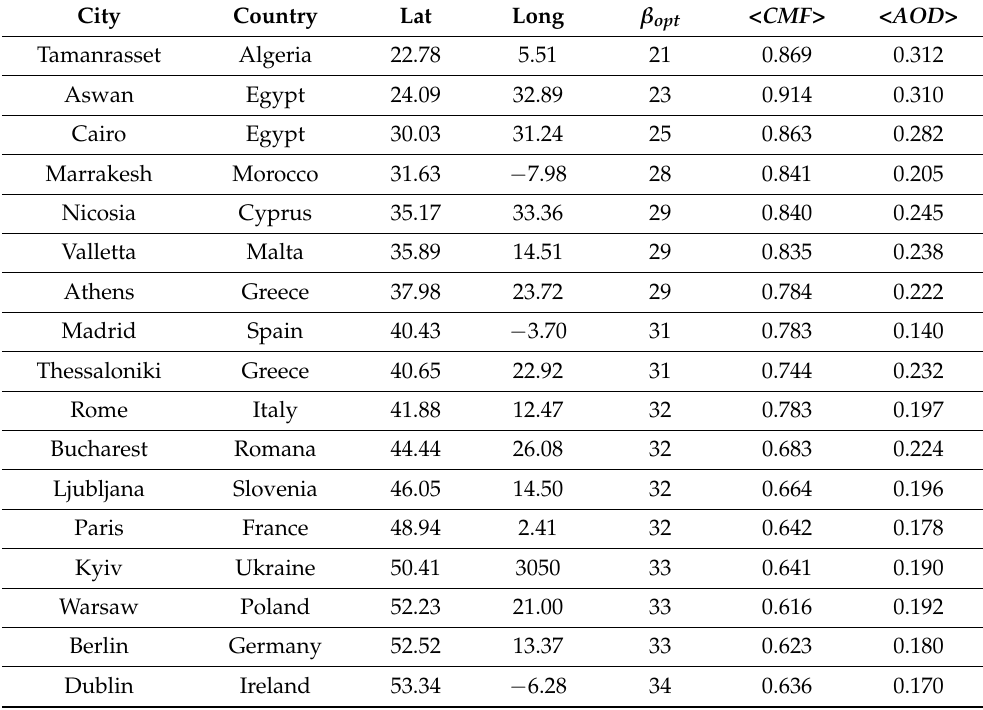
Table 3. Latitude and Longitude of Cities used in the study, alongside with mean CMF and AOD and the calculated optimum tilt angle β for the period